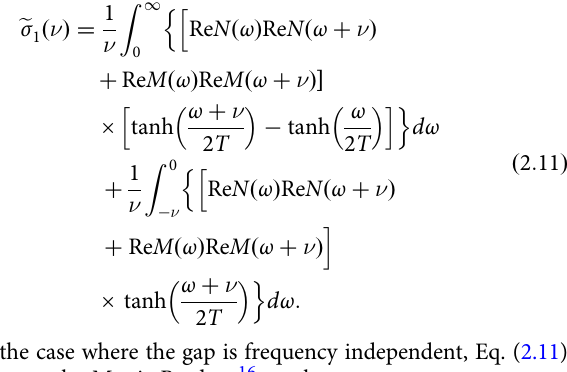
ffiffiffiffiffiffiffiffiffiffiffiffiffiffiffiffiffiffiffiffiffiffiffiffiffiffiffiffi ω þ ν